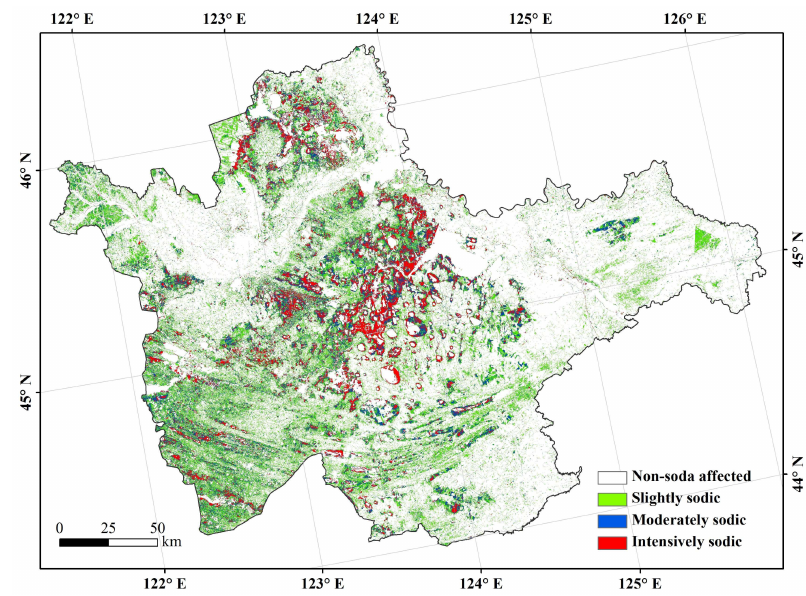
Figure 3. Distributions of soil sodicity in the west Jilin.